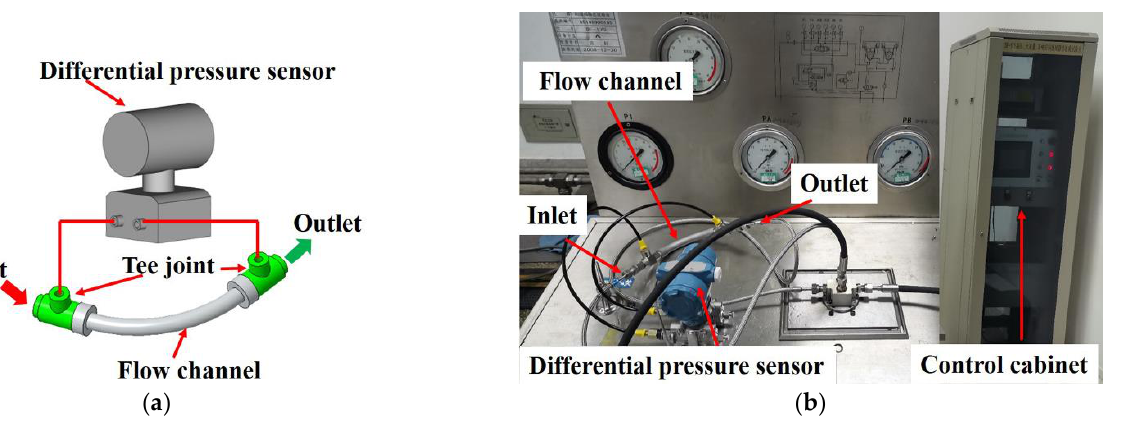
Figure 4. ( a ) A schematic of the pressure loss test rig; ( b ) a photo showing the test rig.